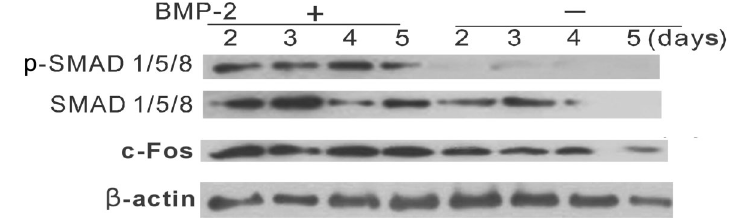
Figure 7. Western blot showed the expression of phospho-SMAD (p-SMAD) 1/5/8 and c-Fos. RAW 264.7 cells were treated with 30 ng/mL RANKL and 150 m g/mL titanium particles for 1 h and subsequently treated or not with 50 ng/mL BMP-2 at indicated